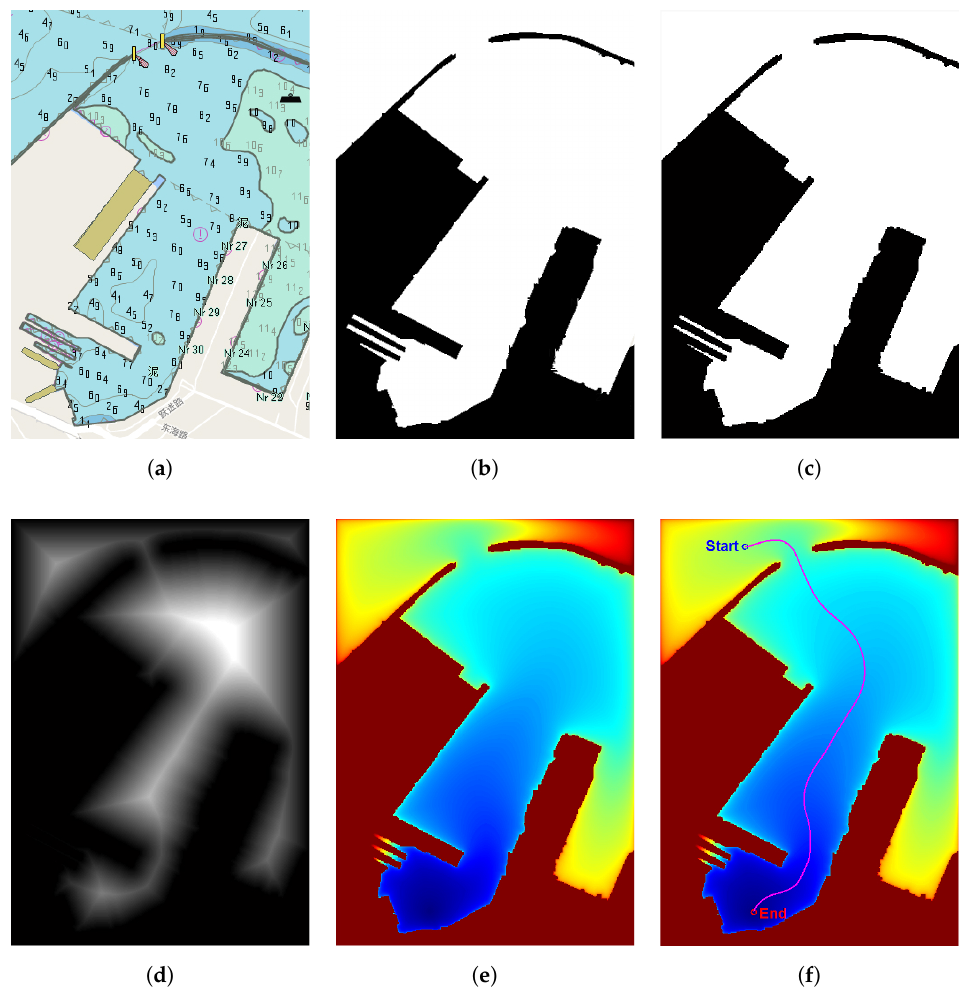
Figure 8. Steps of the tunable fast marching square (TFMS) method in a real sea area. ( a ) Electronic chart of the sea area; ( b ) Initial binary map; ( c ) Expanded binary map; ( d ) Potential map V with Saturation 0.9; ( e ) Arrival time matrix T ; ( f ) Path obtained after applying gradient descent on T